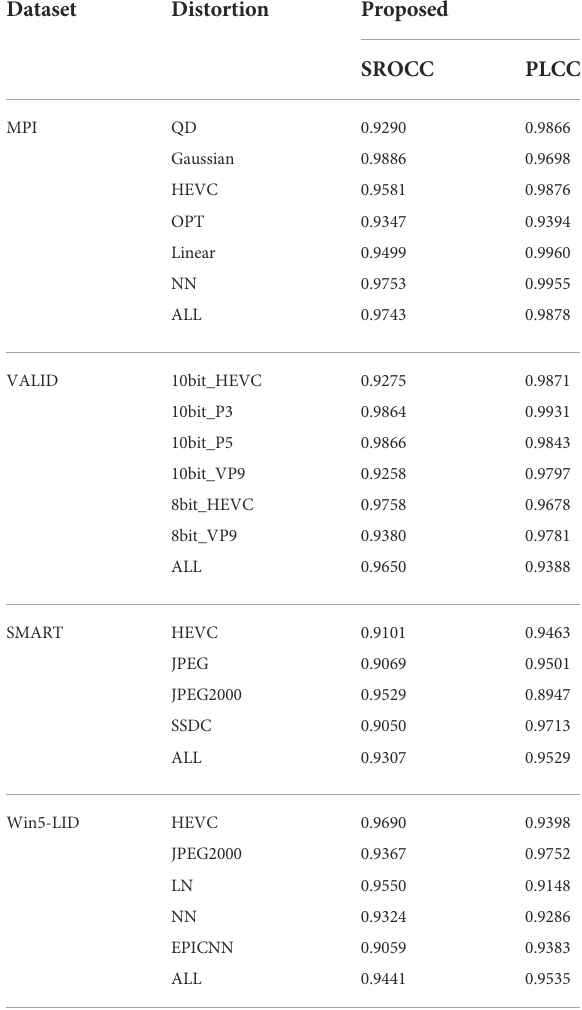
TABLE 2 Mean SROCC and PLCC values for VALID, SMART, MPI, and Win5-LID datasets obtained by 1,000 simulations of RFR.